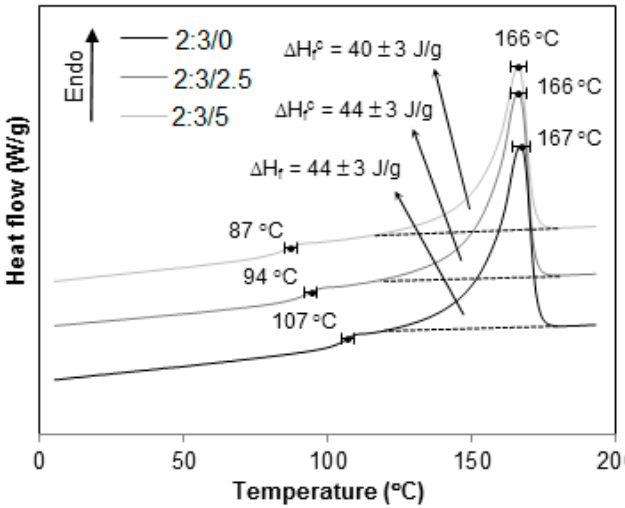
Figure 11. DSC thermograms for 2:3 PP/HIPS blends with 0, 2.5 and 5 phr of CNSL.